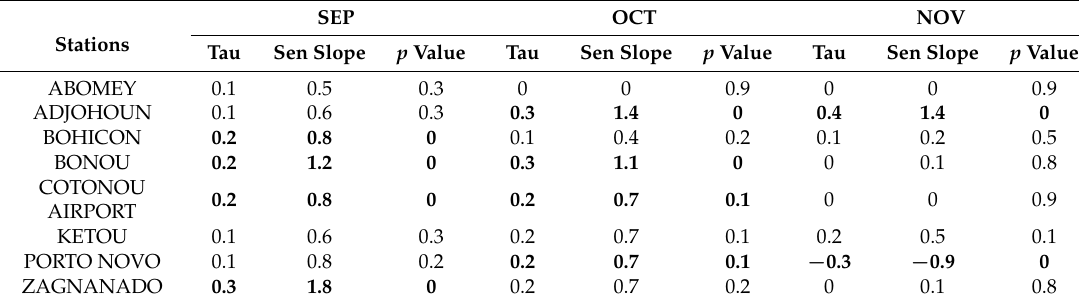
Table 9. Monthly trend analysis of ten-day precipitation amount (RX10day) during high